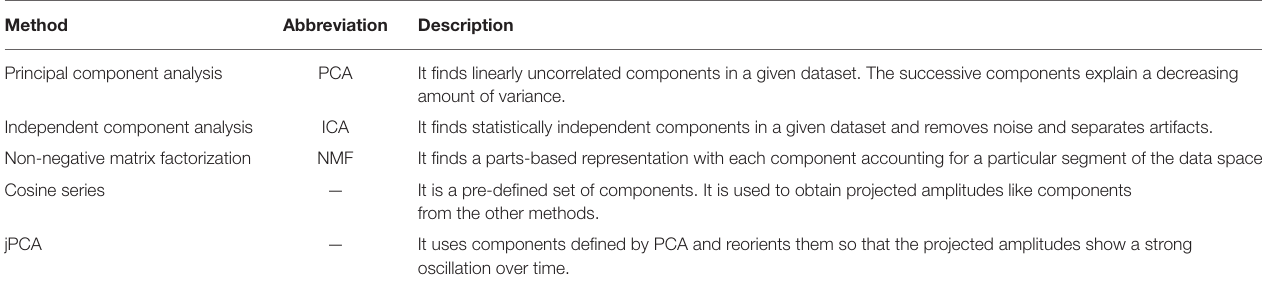
TABLE 1 | A list of methods, their abbreviations and short